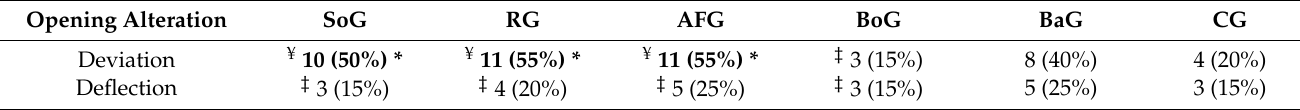
Table 8. Opening alteration: comparison between different sports and controls.